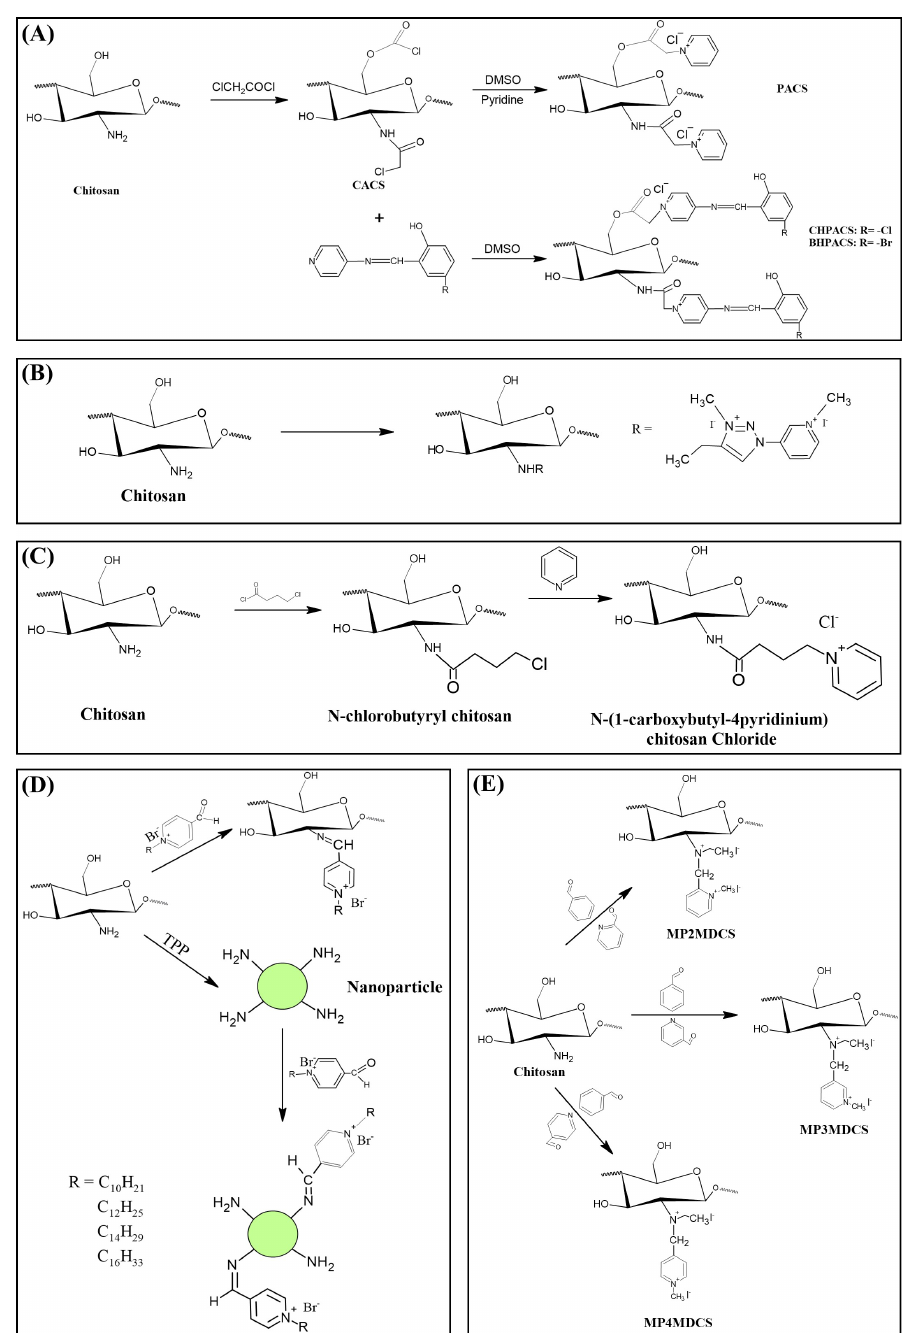
Figure 6. Synthetic route to obtain different quaternized chitosan derivatives with pyridinium salts: ( A ) PACS, CHPACS and BHPACS, ( B ) chitosan derivative containing N-methyl-1,2,3-triazoliumand N-methyl-pyridinium, ( C ) N-(1-carboxybutyl-4-pyridinium)chloride chitosan, ( D ) CS and NP chitosans and ( E )